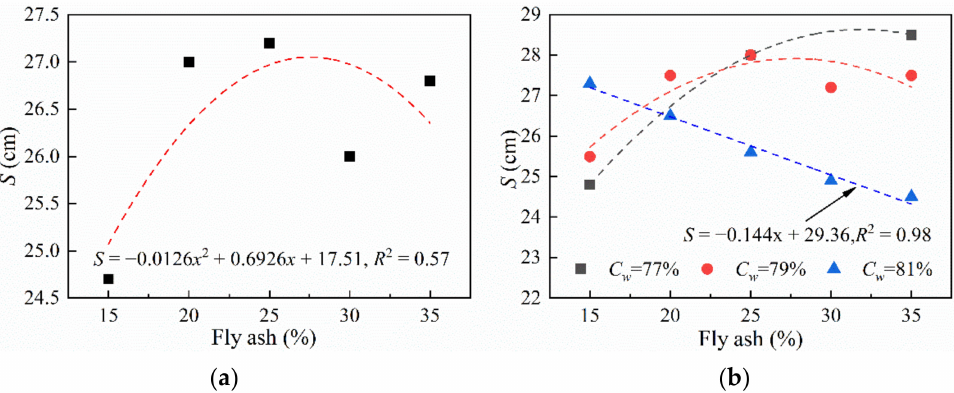
Figure 3. Variation of the slump with the fly ash addition: ( a ) average slump; ( b ) slumps with varying